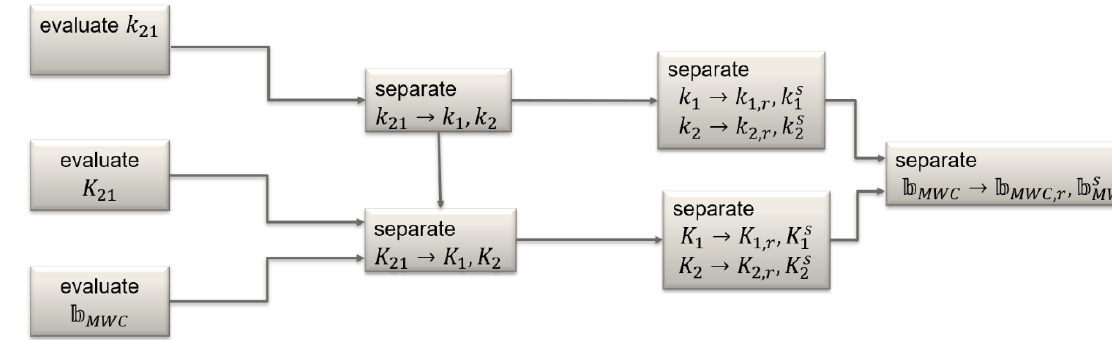
Figure 3. Flowchart of bias correction generation.